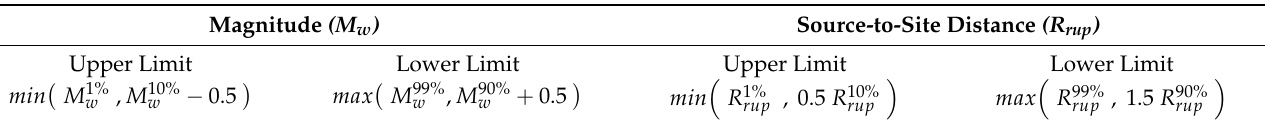
Table 1. Bounding limits proposed by Tarbali and Bradley (2016)